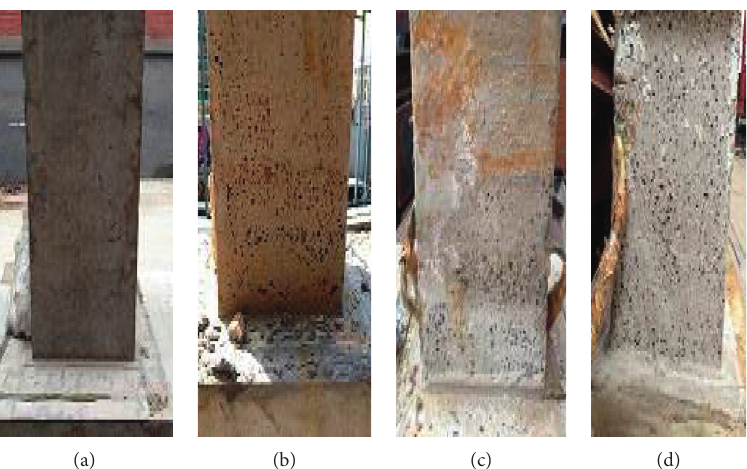
Figure 5: Visual damage of specimens under different levels of corrosion: (a) SC-1 (0 cycles); (b) SC-2 (240 cycles); (c) SC-3 (360 cycles); (d) SC-4 (480